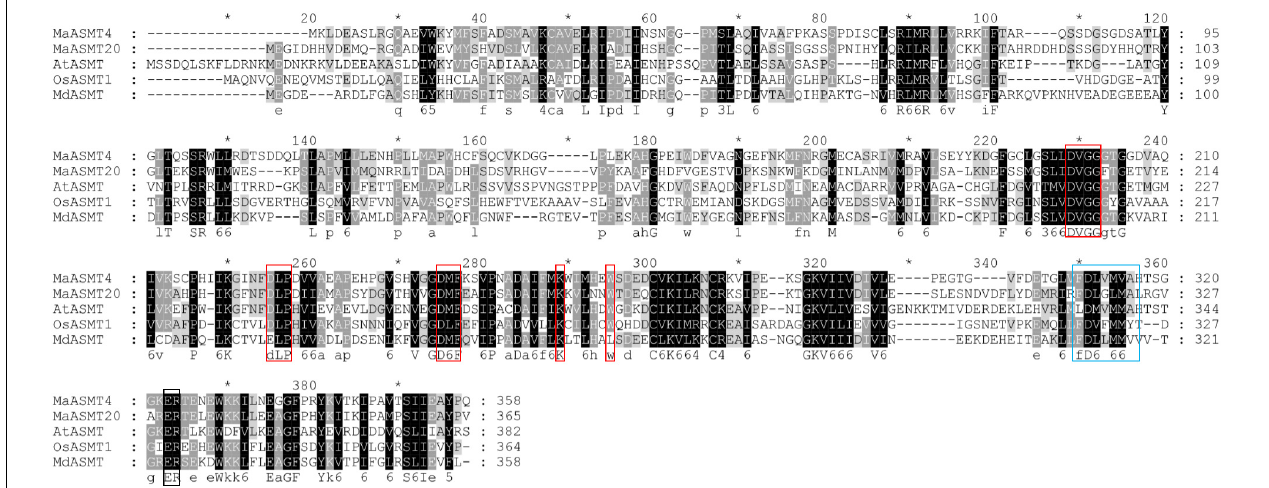
FIGURE 4 | Multiple sequences alignment of MaASMTs with the ASMTs from other plant species. The positions of the different conserved domains are represented by different colored boxes. The conserved motif for the S -adenosine- L -methionine binding is boxed in red, putative substrate-binding residues are boxed in black, and catalytic residues are boxed in blue.